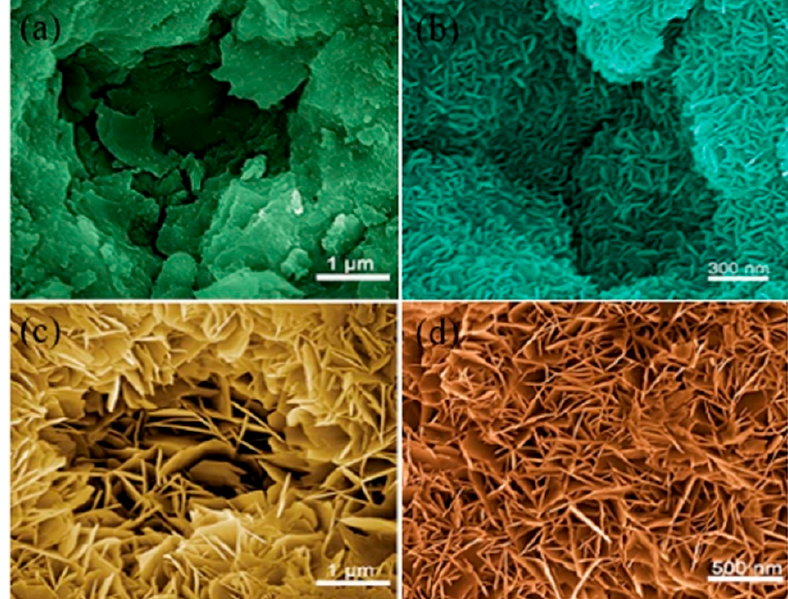
Figure 5. ( a – d ) SEM images showing the surface morphologies of the “A” (anodized film), “As” (anodized film sealed by boiling water), “A-LDH” (LDH film formed directly on the anodized film), and “AS-LDH” (LDH film formed on the sealed anodized film), respectively [67].